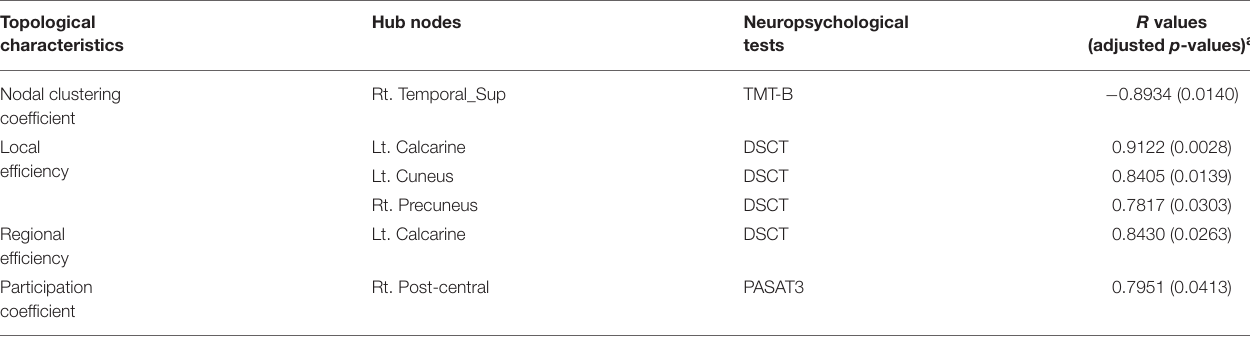
TABLE 5 | The topological characteristics of hub nodes in association with cognitive test performance in patients with